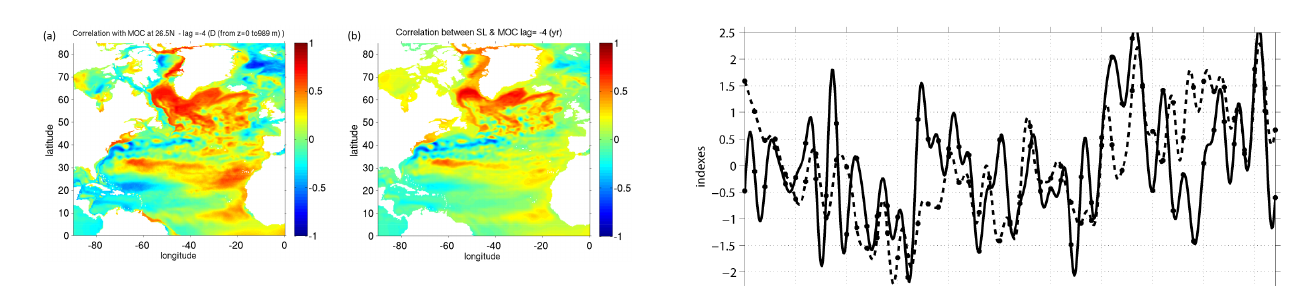
Figure 7. Correlations of the annual AMOC-Ek at 26.5 ◦ N with the top 1000m averaged density anomalies (a) and sea level (b) in ORCA025-G70, for the 45-year period 1960–2004 inclusive; AMOC-Ek variability lags by 4 years. The correlations between AMOC-Ek and sea level are multiplied by − 1.